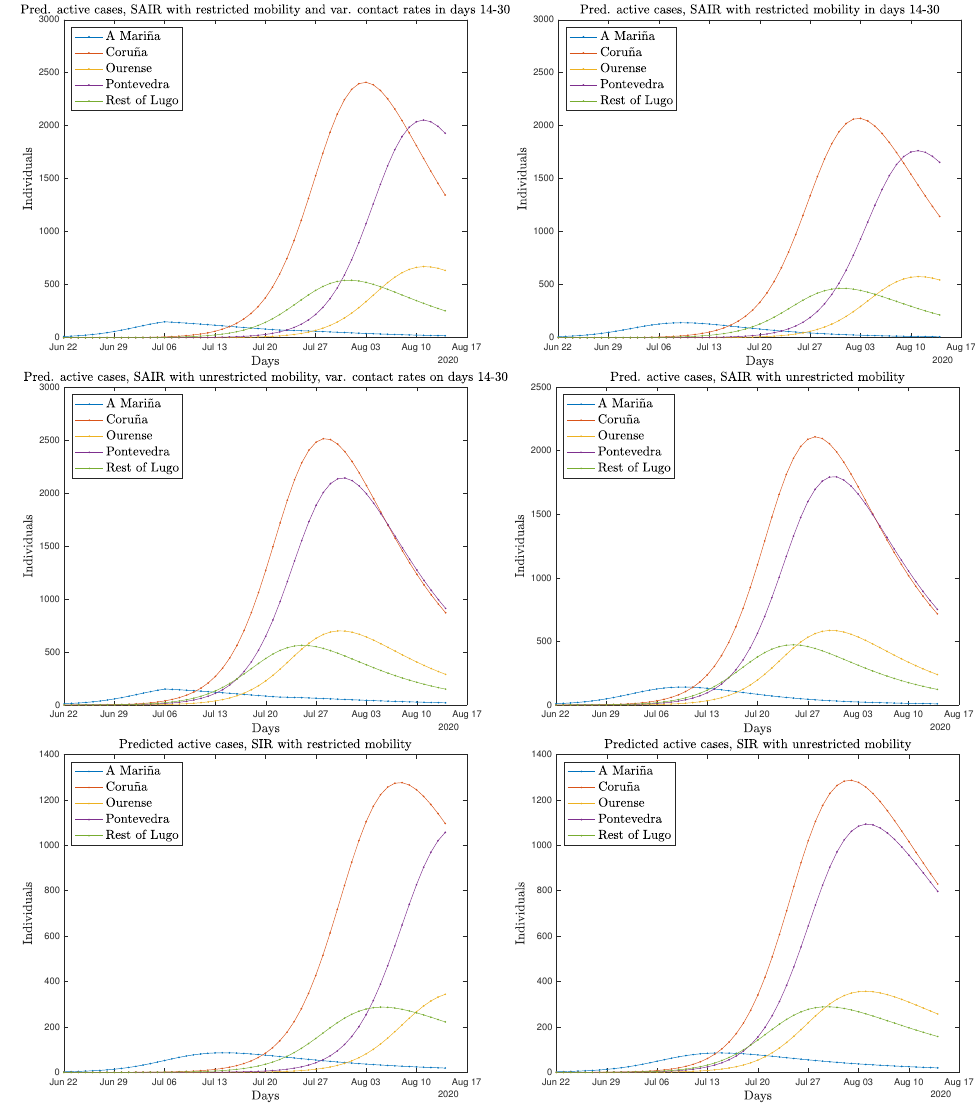
Figure 5. Predicted active cases (A+I) for different simulations of the A Mariña outbreak. From left to right and from top to bottom: SAIR, with mobility restrictions and reduced contact rates applied on days 14–30; Same experiment with constant contact rates; SAIR, without mobility restrictions and reduced contact rates applied on days 14–30; SIR with restricted mobility on days 14–30; SIR with unrestricted mobility on days